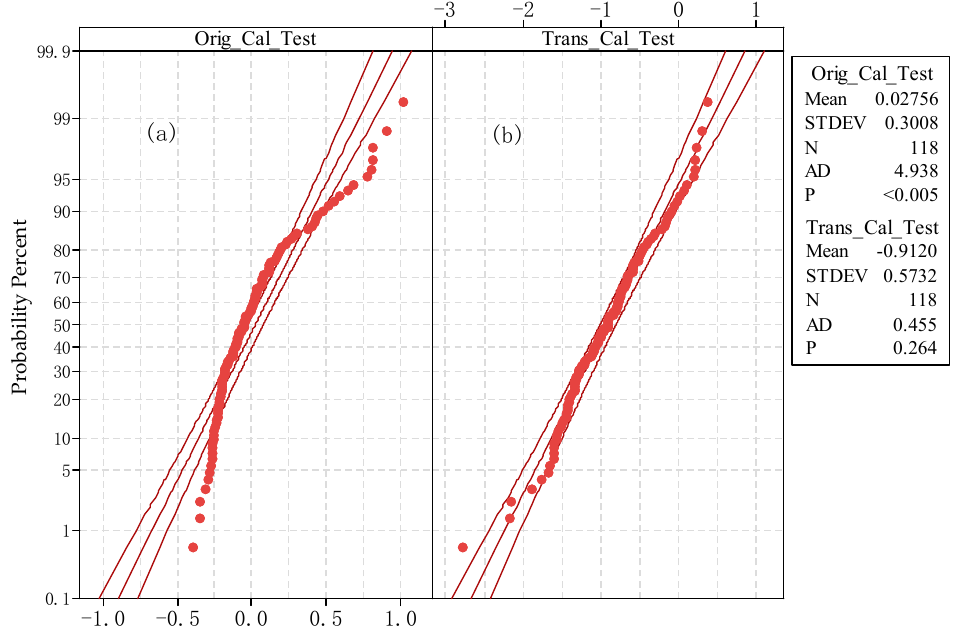
Figure 5. A–D tests of original and transformed di ff erence data in the calibrated model: ( a ) original and ( b ) transformed di ff erence data.